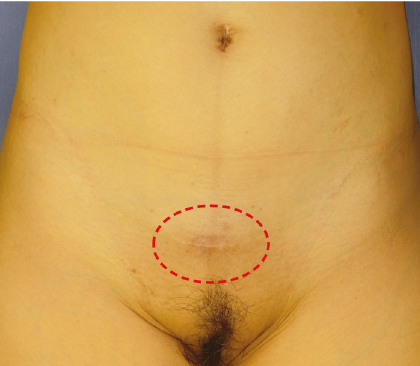
Figure 1: Findings on initial examination. A palpable subcutaneous mass is seen at the position surrounded by the red dashed